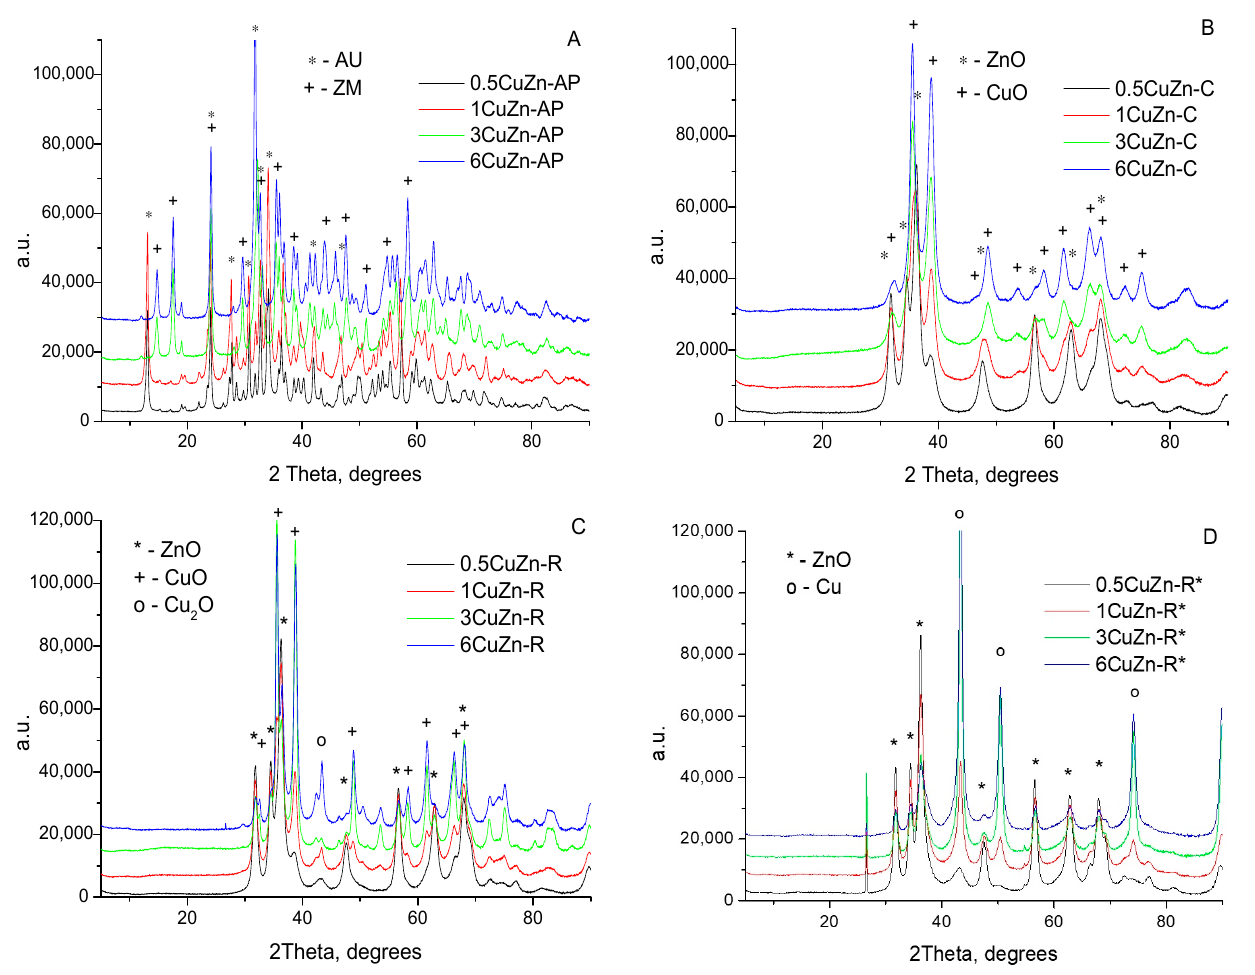
Figure 1. XRD patterns of the as-prepared CuZn precursors ( A ), calcined mixed oxides ( B ), samples reduced by a standard method ( C ), samples reduced and treated with MeHe ( D ).